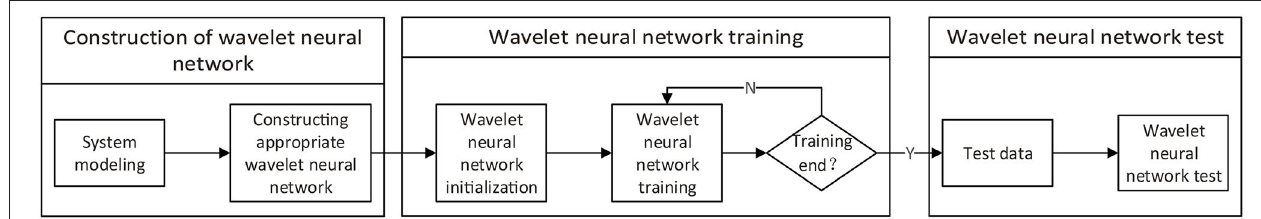
FIGURE 2 | The algorithm flow chart of wavelet neural network.